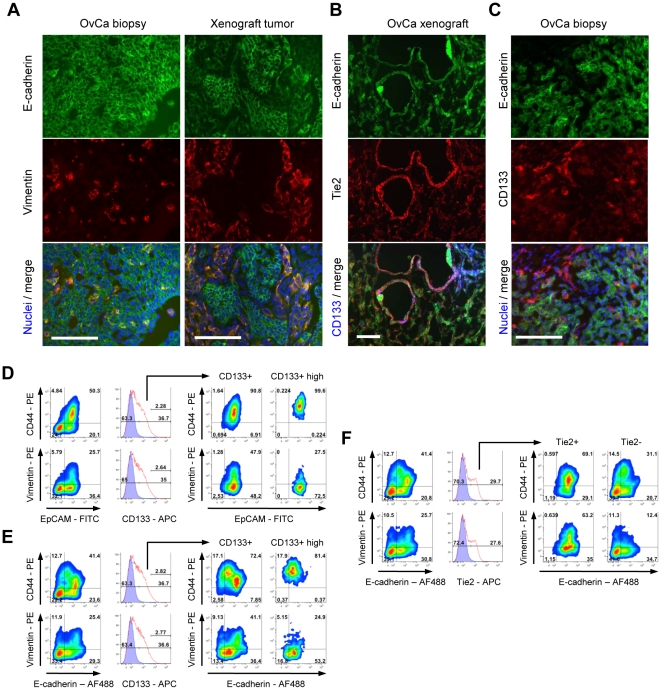
Phenotypic analysis of ovarian cancer xenografts and biopsies.
A) Existence of E/M hybrid cells in situ. E-cadherin+/vimentin+ cells are present biopsies and tumor xenografts. Shown are images of ovc316-biopsy and ovc316-X. Similar staining was found for ovc100506-biopsy/ovc100506-X, ovc100728-biopsy/ovc100728-X, and ovc100914-biopsy/ovc100914-X. B) Correlation of E-cadherin (green) and Tie2 (red) positivity in ovarian cancer biopsies. CD133high cells (blue) are Tie2low and E-cadherinintermediate. Shown are images of ovc316-biopsy and ovc316-X. Similar staining was found for ovc100506-biopsy/ovc100506-X, ovc100728-biopsy/ovc100728-X, and ovc100914-biopsy/ovc100914-X. C) CD133high cells have low levels of membrane E-cadherin. E-cadherinhigh cells show punctated membrane CD133 staining. Shown are images of ovc316-biopsy and ovc316-X. Similar staining was found for ovc100506-biopsy/ovc100506-X, ovc100728-biopsy/ovc100728-X, and ovc100914-biopsy/ovc100914-X. The scale bar is 40µm. D–F) Triple-color flow cytometry analysis of ovc316-X for epithelial markers (x-axis), mesenchymal features (y-axis), and for cancer stem cell marker CD133 (histogram plots). D) Xenografts contain epithelial cells, epithelial/mesenchymal (E/M) hybrid cells, and cells that are negative for all markers. CD133+ cells are almost exclusively in an E/M hybrid stage based on EpCAM/CD44 analysis. CD133high cells are EpCAMhigh, CD44high and vimentinlow. E) Replacement of EpCAM with E-cadherin reveals higher diversity within xenografts. CD44high cells are E-cadherinlow/intermediate. CD133+ cells are divided into two clear sub-fractions. Fraction 1: E-cadherinlow/intermediate/CD44high and fraction 2: E-cadherinhigh/CD44intermediate. CD133high cells are E-cadherinlow/intermediate, CD44high and vimentinlow. The positivity of CD44 and vimentin correlates inversely. F) Tie2 marks cells that are E-cadherinhigh/CD44intermediate and predominantly positive for vimentin. Tie2− cells are highly depleted for CD133 sub-fraction 2 and for E-cadherincells/vimentinhigh cells.